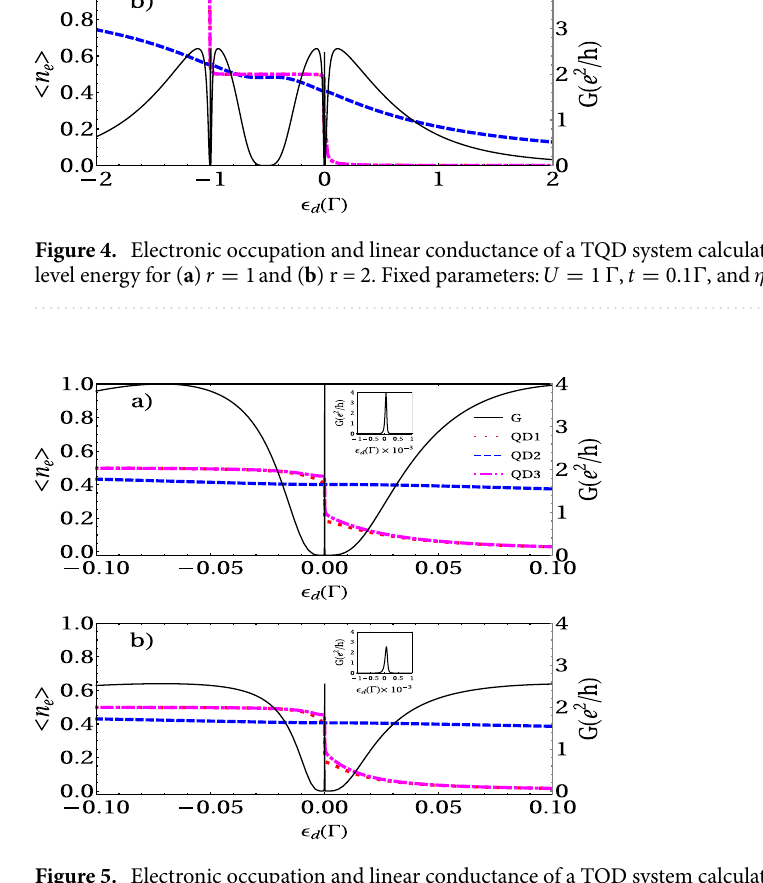
0 Ŵ , for ( a ) r 1 and ( b ) r = 2. Fixed parameters: U = =